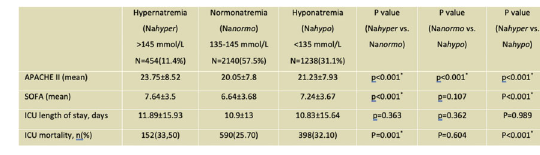
Table 2 (abstract 001501). characteristics and outcomes of dysnatremic